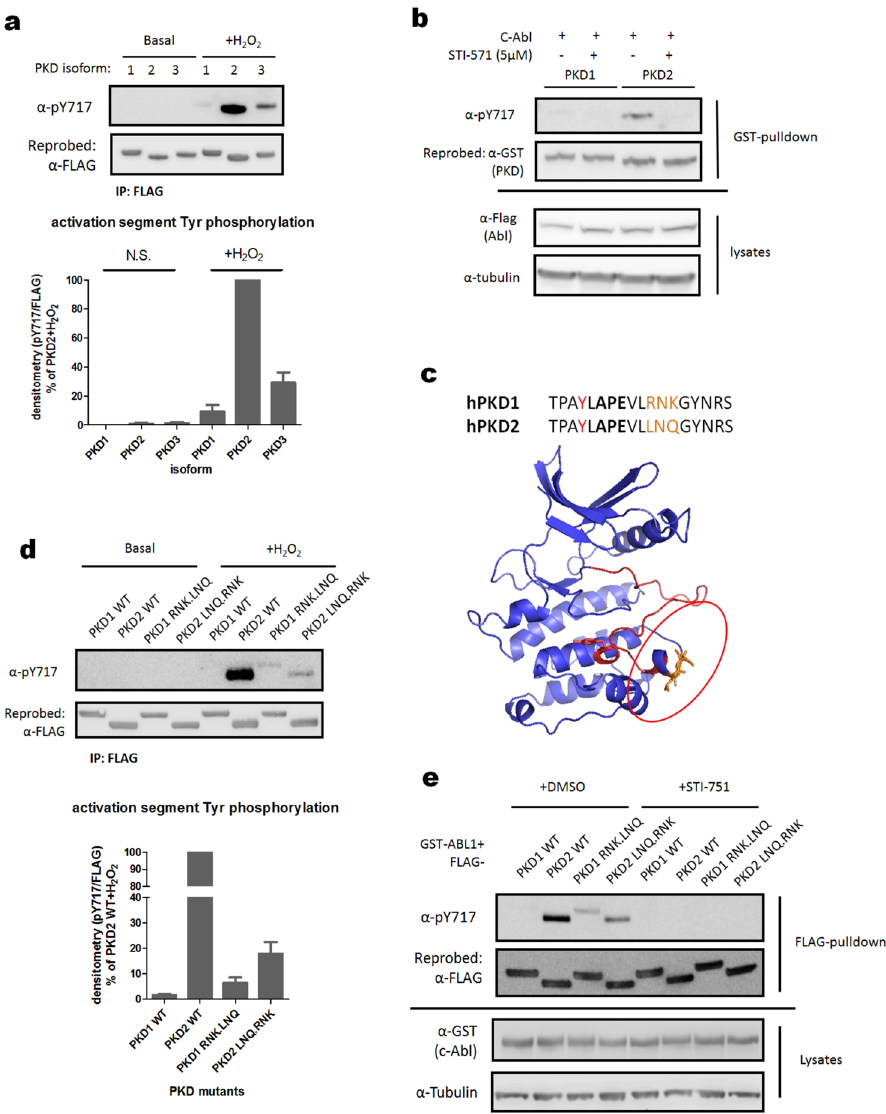
Figure 5. The PKD2-specific LNQ motif in the activation segment underlies the differential phosphorylation of PKD isoforms at Tyr in the P + 1 loop during oxidative stress. ( a ) The three hPKD isoforms are not equally phosphorylated at Tyr in the activation segment upon oxidative stress. HEK293 cells were transfected with FLAG- tagged wild type (WT) PKD1/2/3. 48 h after transfection cells were stimulated with H 2 O 2 (10 mM, 10 min). FLAG immunoprecipitates were subjected to western blot and probed with the indicated antibodies. Quantification of three independent experiments is shown. Western blots were cropped for clarity; uncropped images can be found in Supplementary Fig. S18. ( b ) Abl does not phosphorylate PKD1 at the activation segment Tyr residue. HEK293 cells were transfected with wild type (WT) GST-PKD1/2. 48 h after transfection, cells were pretreated with STI- 571 (5 µ M) or vehicle and PKD1/2 were precipitated from the cells using Glutathione-sepharose beads. Samples were subjected to western blot and probed with the indicated antibodies. Western blots were cropped for clarity; uncropped images can be found in Supplementary Fig. S19. ( c ) Location of the divergent PKD1/2 sequence in the primary and tertiary structure (PKD2 homology model generated by the Phyre2 server). ( d ) Swapping the RNK motif of PKD1 with the LNQ motif in PKD2 results in altered activation segment Tyr phosphorylation. HEK293 cells were transfected with wild type (WT) PKD1/2 or the exchange mutants. 48 h after transfection, cells were stimulated with H 2 O 2 (10 mM, 10 min) or left unstimulated. FLAG immunoprecipitates were subjected to western blot and probed with the indicated antibodies. Quantification of three independent experiments is shown. Western blots were cropped for clarity; uncropped images can be found in Supplementary Fig. S20. ( e ) Swapping the RNK motif of PKD1 with the LNQ motif in PKD2 results in altered activation segment Tyr phosphorylation by Abl. HEK293 cells were co-transfected with FLAG-tagged wild type (WT) PKD1/2 or the exchange mutants and GST-tagged Abl. Prior to lysis, cells were treated with STI-571 (5 µ M) or DMSO. FLAG immunoprecipitates were subjected to western blot and probed with the indicated antibodies. Western blots were cropped for clarity; uncropped images can be found in Supplementary Fig.